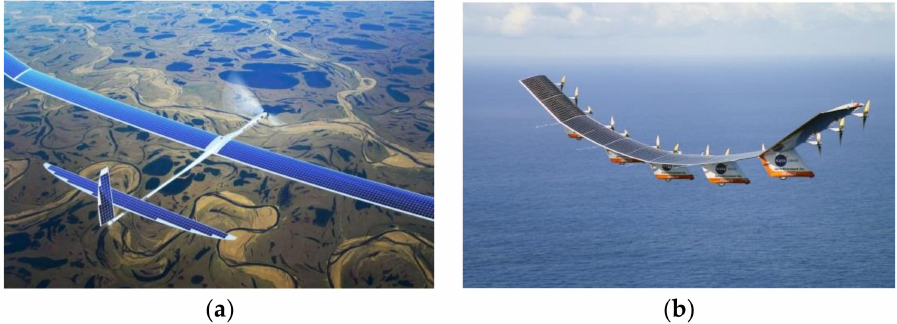
Figure 7. Solar-powered drones ( a ) Google’s project, ( b ) Facebook’s project